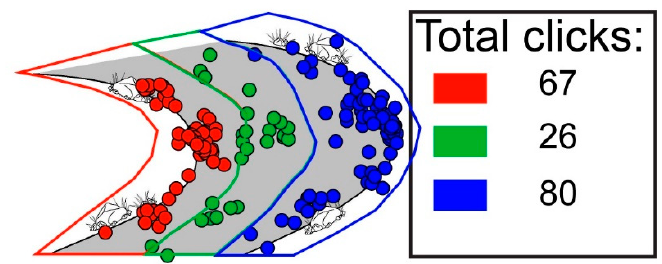
Figure 7. Polygons and student clicks in response to the prompt, “Click in the river where you expect to find the greatest rate of erosion in the riverbed”. The correct region, labeled in blue ( n = 80), is the outside of the river bend. The region labeled in red ( n = 67) and green ( n = 26) will have relatively lower velocity and erosion.